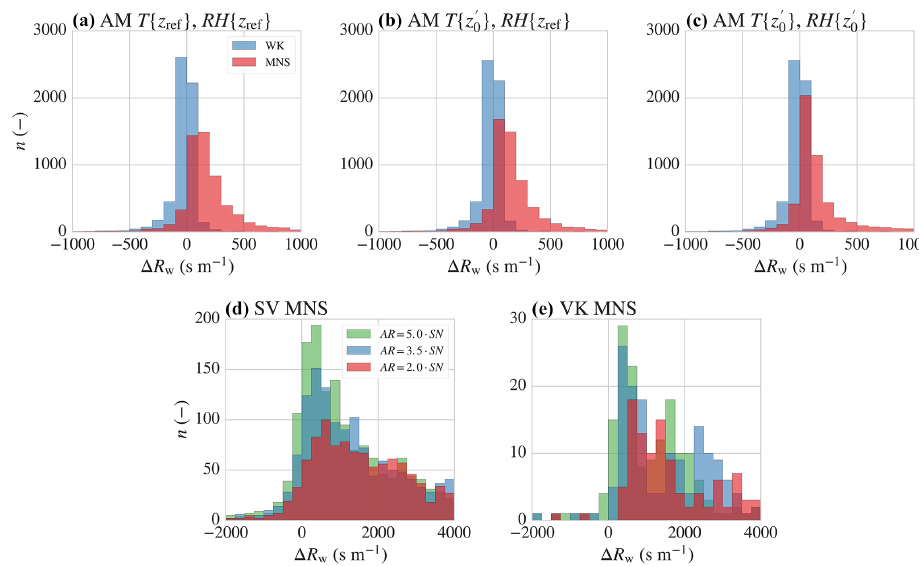
Figure 8. Sensitivity of differences in measured and modeled non-stomatal resistances to the use of measured air vs. surface temperature and relative humidity estimates. (Upper row) Exemplary calculations for AM with (a) T and RH at the reference height, (b) T at the notional ) , and (c) T and RH at z (cid:48) height of trace gas exchange ( z (cid:48) . (Lower row) AR estimated as 2.0, 3.5, and 5.0 times the [SO 2 ] / [NH 3 ] ratio 0 0 SN for (d) Solleveld and (e) Veenkampen. Note the asymmetric horizontal axis in (d, e) . Data are binned into 100sm − 1 bins for (a–c) and 250sm − 1 bins for (d–e) to ensure visual